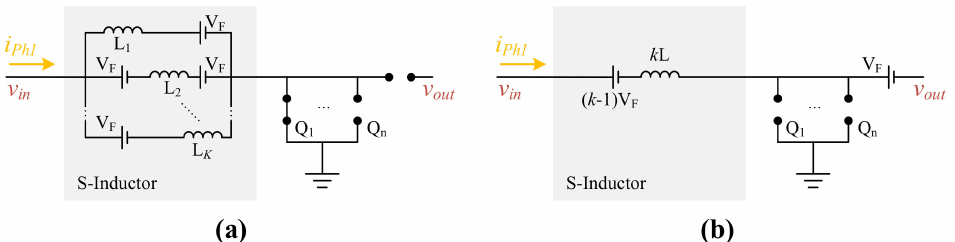
Figure 2. HGBoost equivalent states: ( a ) ON-State. ( b )